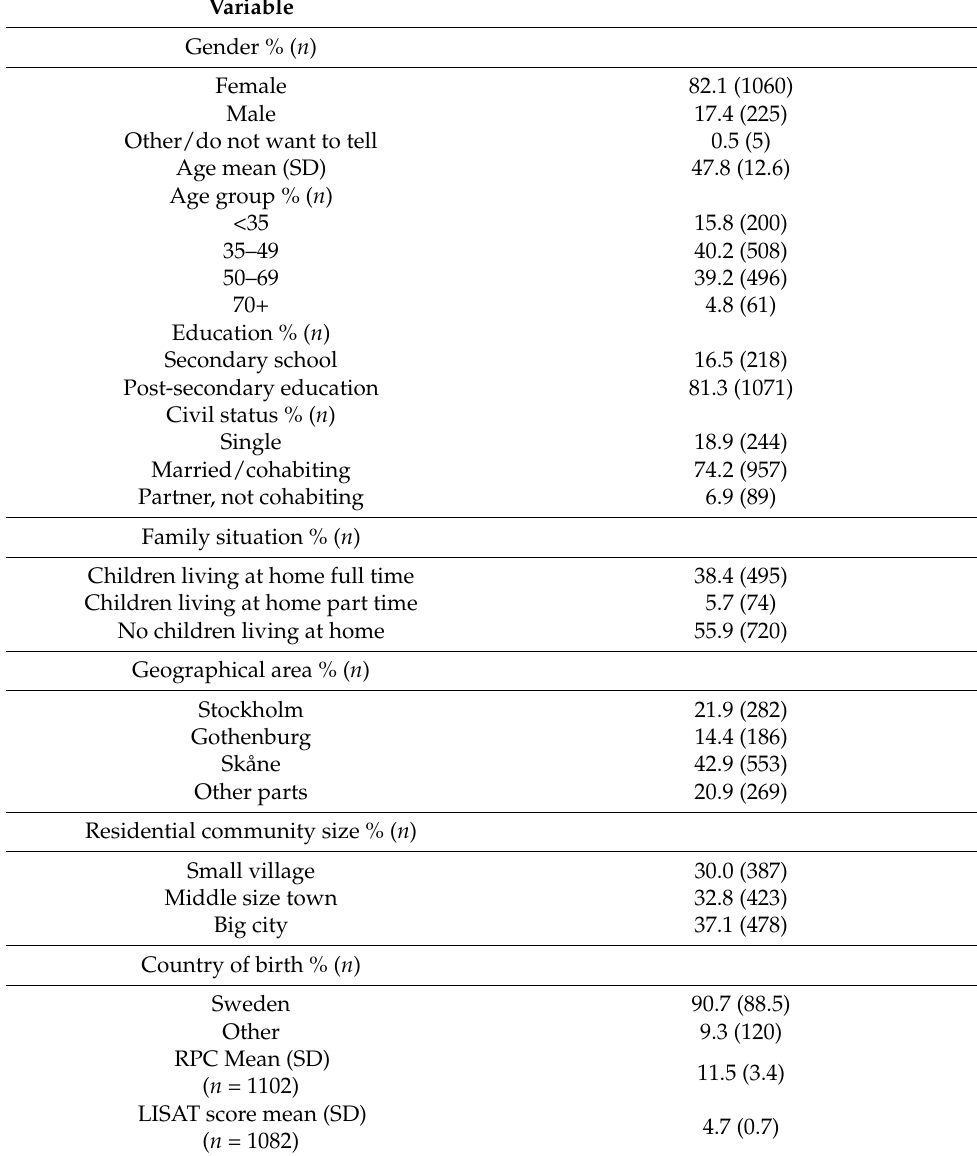
Table 1. Description of study sample ( n =